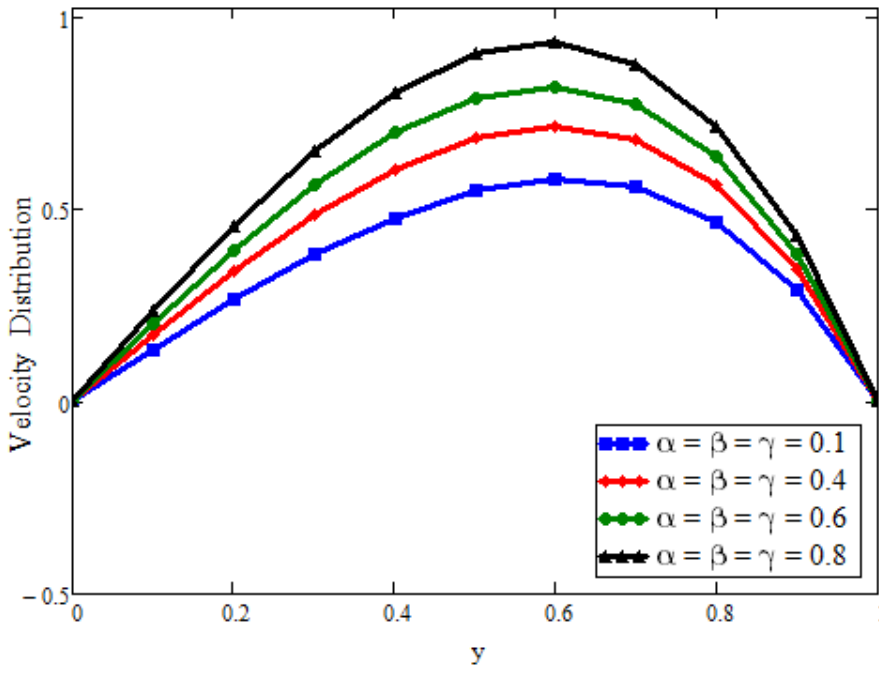
Figure 3. Velocity distribution against y due to for fractional parameters 𝛼, 𝛽, 𝛾 for large time, when t = 3 , Pr = 6.2 , 𝜙 (cid:3035)(cid:3041)(cid:3033) = 0.04, Gr = 15, M = 0.1.